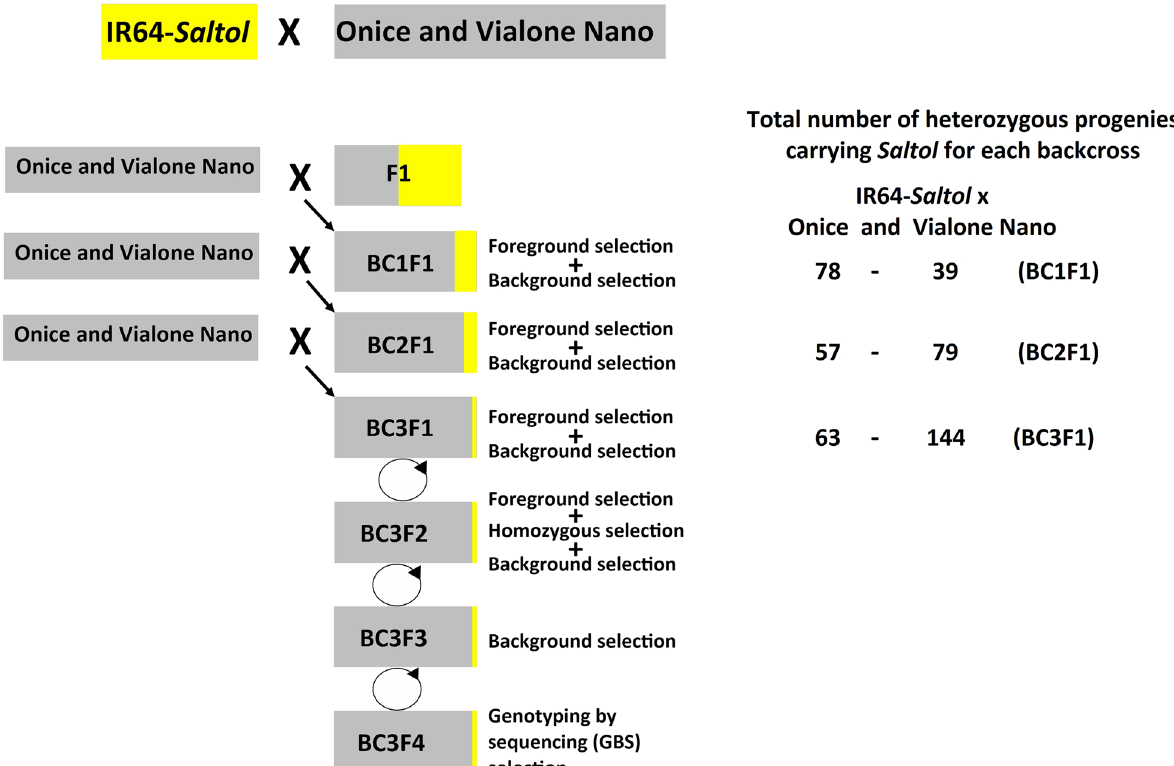
Fig. 1 Flowchart of the Marker Assisted Back Cross (MABC) scheme used for Saltol QTL introgression in temperate japonica rice varieties Onice and Vialone Nano. The selected BC 3 F 4 were used for field evaluations and hydroponic